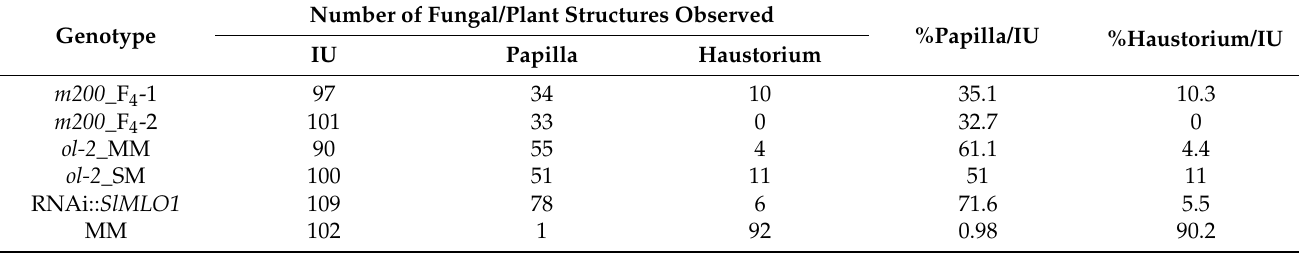
Table 1. Oidium neolycopersici development 72 h after the artificial inoculation. Approximately 100 infection units (IU = fungal spore producing a germination tube) per genotype were observed and the number of papillae and haus- toria were counted. Subsequently, the percentage of IU showing a papilla or haustorium was